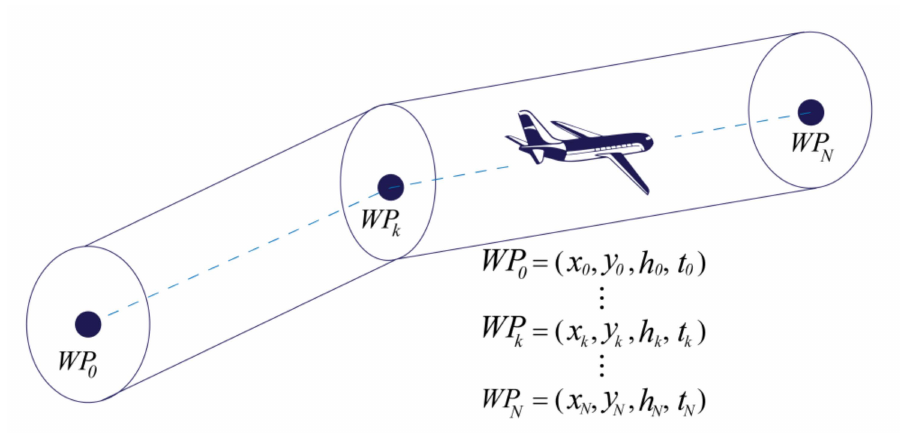
Figure 1. Representation of 4D